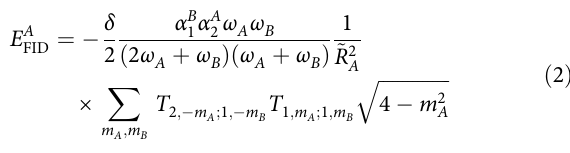
Fig. 1 Model for fi eld-induced dispersion. A system made of two QDOs with distance R between them and a point charge δ placed at a distance ~ R A and ~ R A and B, respectively. QDOs are sketched by B from the oscillator centers blue circles with red oscillation center and yellow oscillating Drude quasiparticle. The external charge is marked by a green